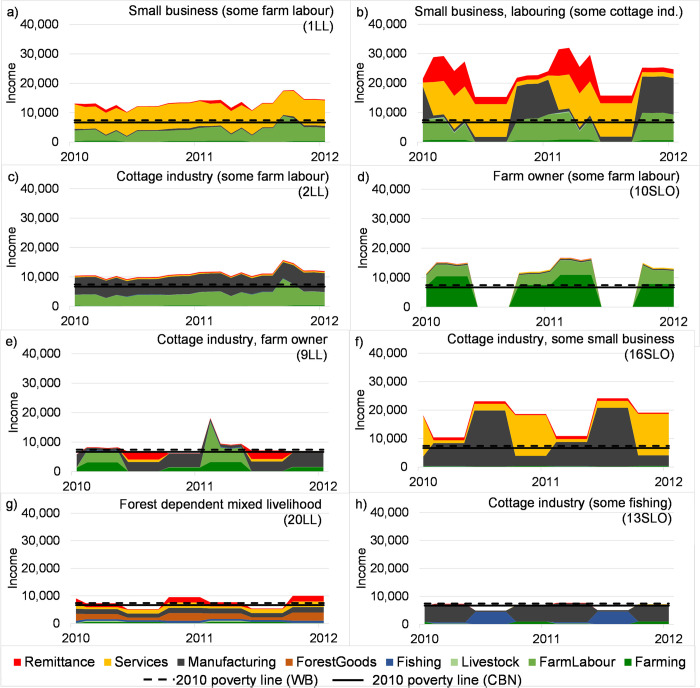
Two year sample of simulated intra- and inter-seasonal livelihood diversification and income-levels (thousand Bangladeshi Taka per month) of selected household archetypes of coastal Bangladesh.Consumption-based World Bank (WB) and Cost of Basic Needs (CBN) poverty lines for 2010 are also shown.